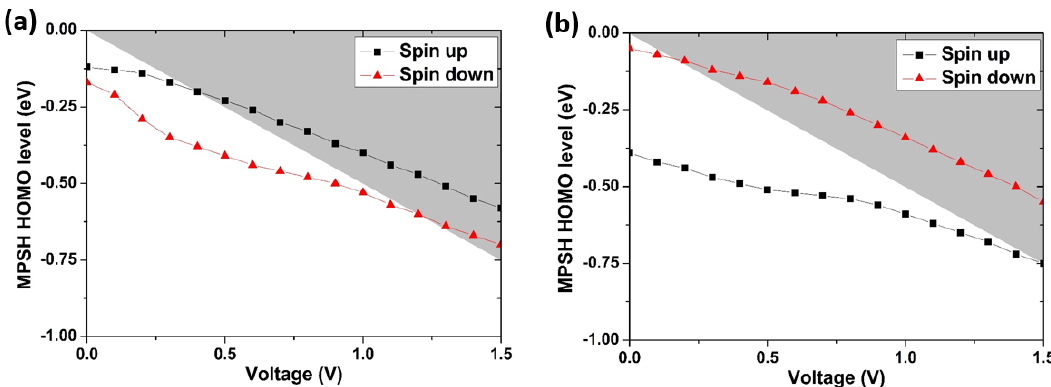
Figure 6. Highest occupied molecular orbital (HOMO) energy levels at the different biases for two models: ( a ) M1; ( b ) M2. The gray shaded area is the bias window.